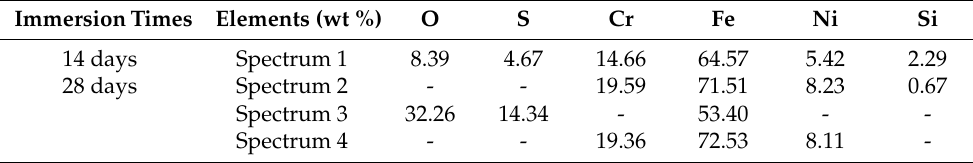
Table 1. EDS analysis results after 14 and 28 days of immersion.